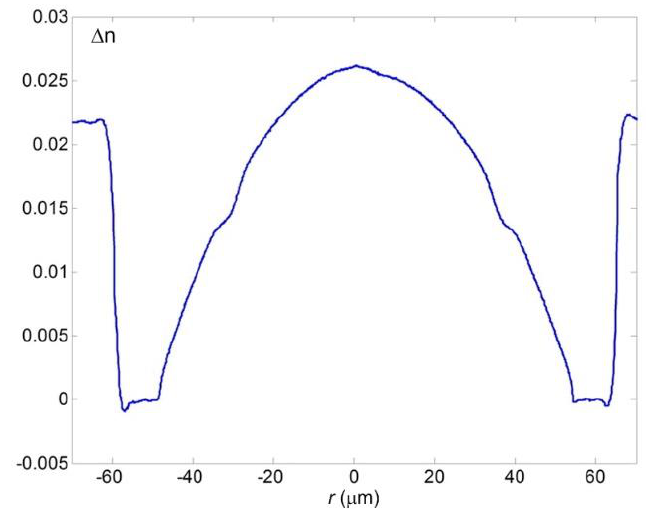
Figure 5. Drawn LOMF 100/125 refractive index profile.